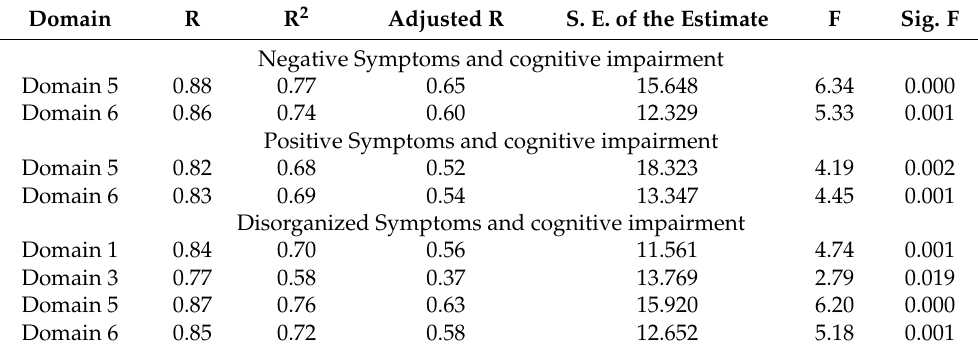
Table 8. Influence of clinical symptoms (positive, negative and disorganization symptoms) and cognitive impairment on WHO DAS 2.0 domains—Multiple regression analysis model